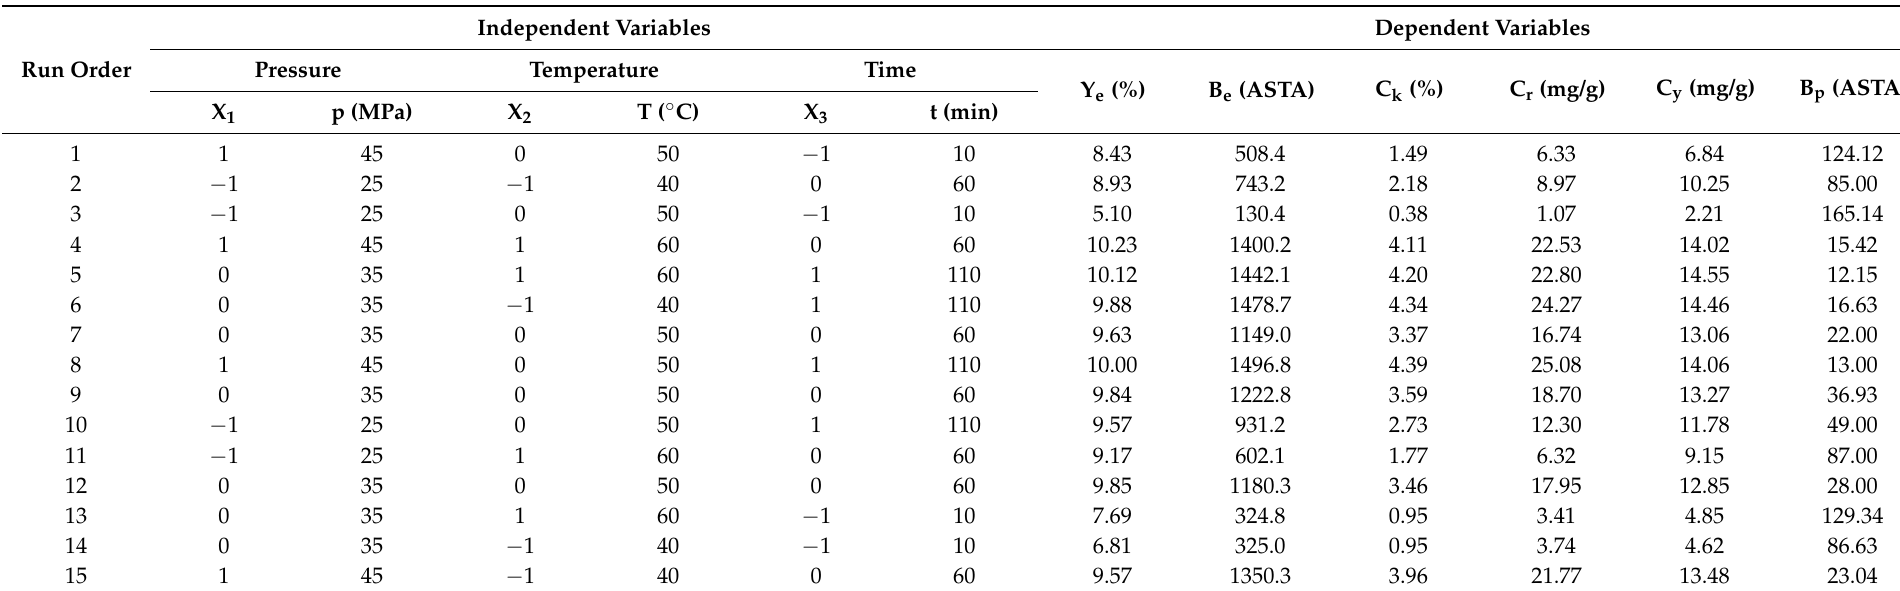
Table 1. Actual-coded independent variables with assumed levels of the BBD design and results of SC-CO 2 extraction of dry